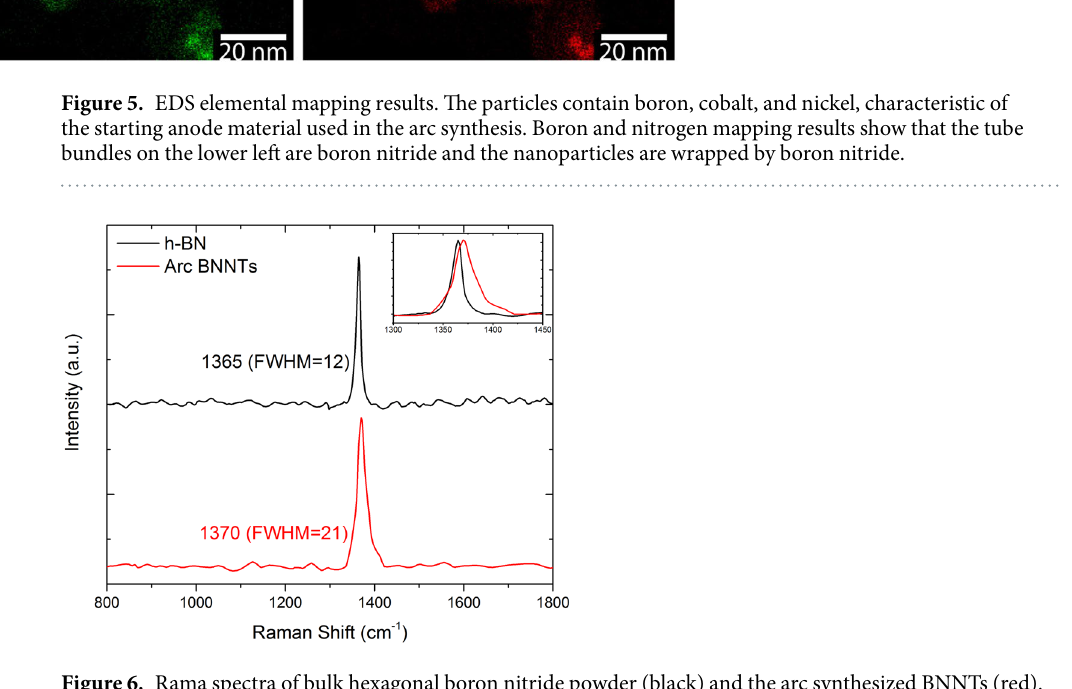
Figure 6. Rama spectra of bulk hexagonal boron nitride powder (black) and the arc synthesized BNNTs (red). Only the E 2g mode of hexagonal boron nitride was observed, and the blue shift observed in the synthesized BNNTs is characteristics of few-layer boron